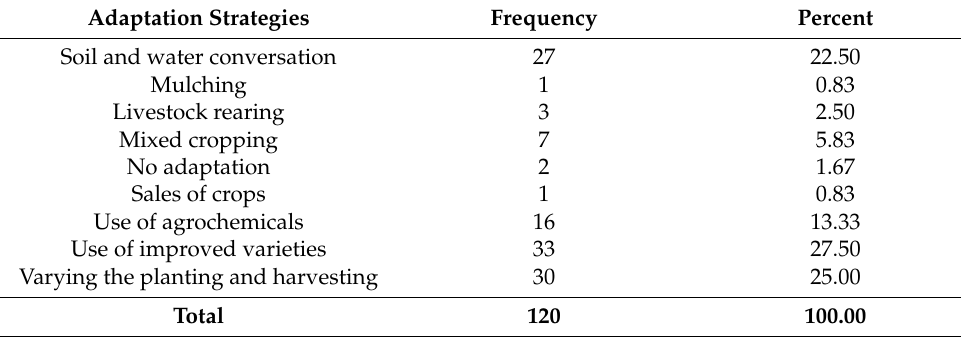
Table 2. Distribution of climate change adaptation